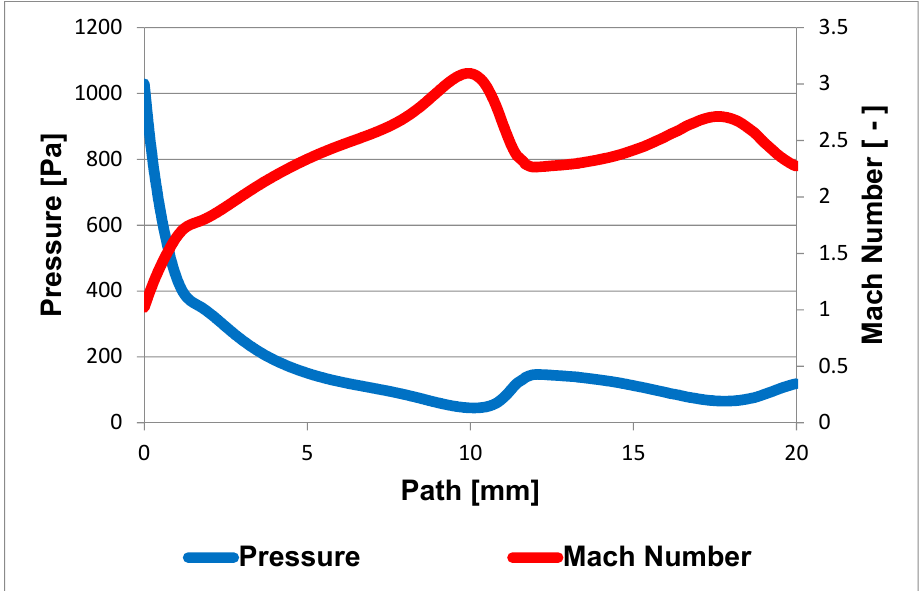
Figure 10. Pressure and Mach number on the path shown in Figure 3.